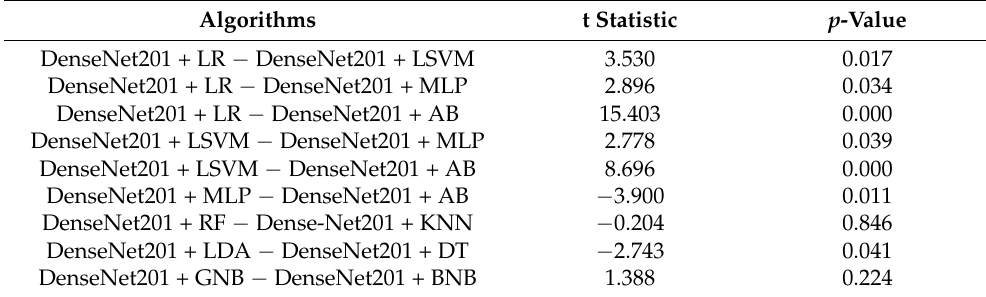
Table 7. 5 × 2 CV paired t -test